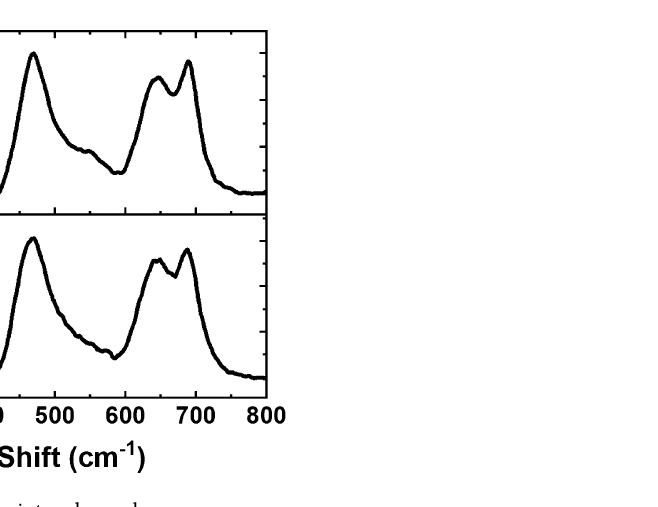
Figure 4. Raman spectra of the sintered samples.